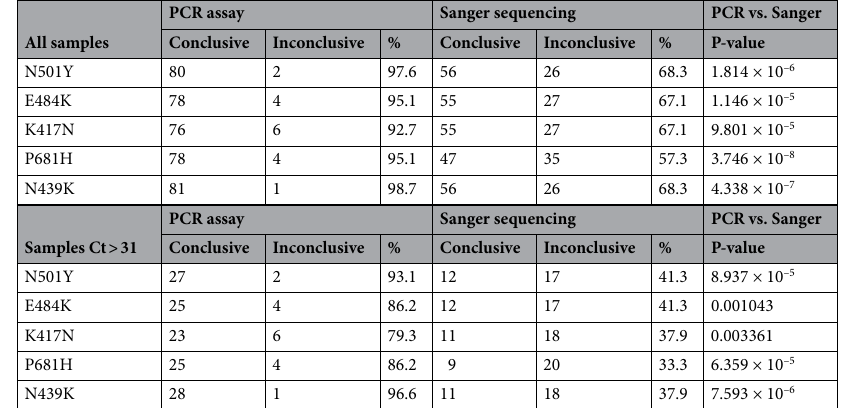
Table 5. Comparison of the sensitivity for the RT-qPCR melting curve assay and Sanger sequencing for the training cohort. The samples are divided into two groups: conclusive and inconclusive. Conclusive is when a result was available of the analysis and inconclusive was when a result was not available. The analysis is made for all the samples and the samples with a low amount of viral SARS-CoV-2 RNA (Ct > 31).